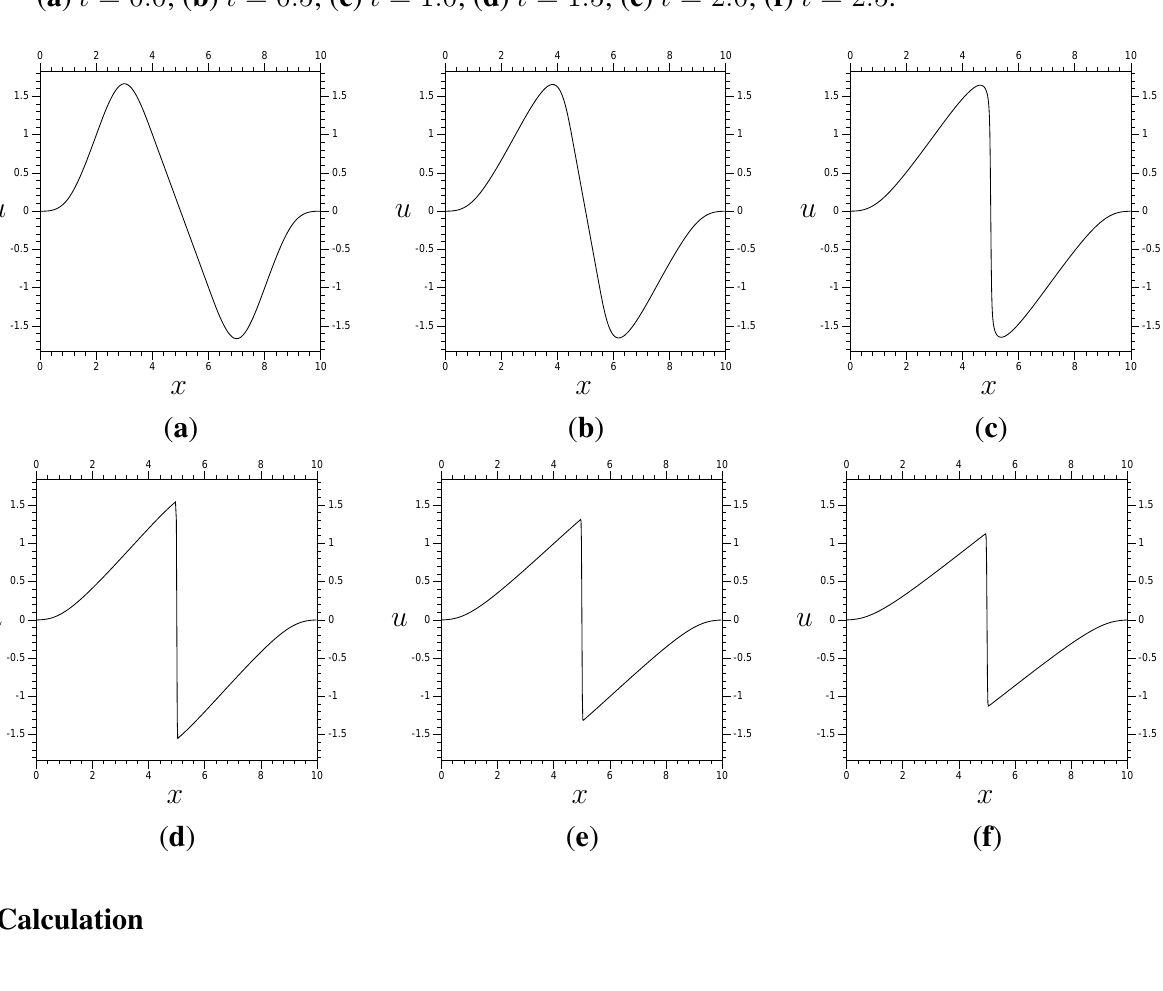
Figure 3. Results for Burgers’ equation with V −